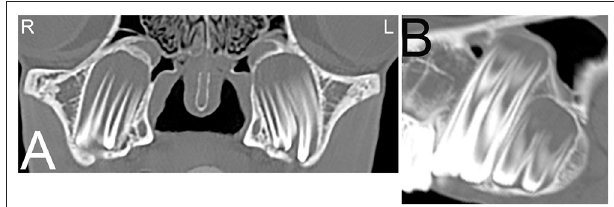
FIGURE 2 | Eruption cysts. Transverse (A) and sagittal (B) computed tomography images of the head at the level of the third maxillary cheek teeth of a 1-year-old Miniature horse. Radiolucent eruption “cysts” are present adjacent to the immature apices of the maxillary cheek teeth and should not be confused with apical or periapical infections in young horses. L, left; R, right.